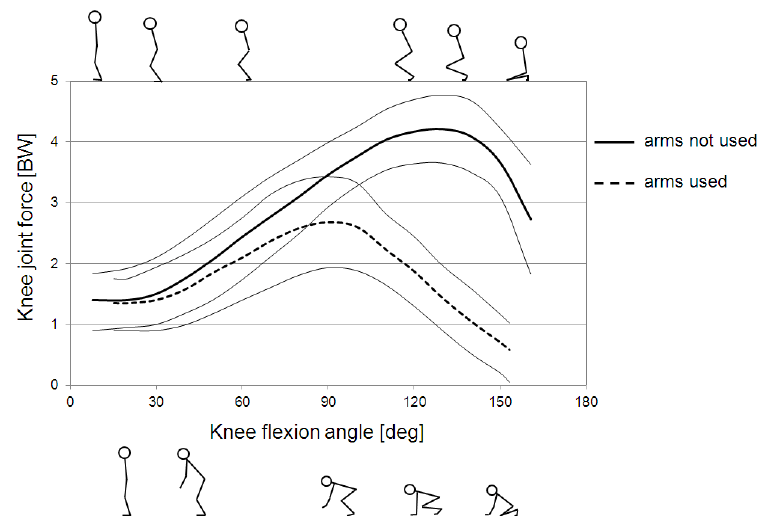
Fig.5 Curves of the mean and standard deviations in knee joint forces as a function of knee angle when rising with legs in parallel.